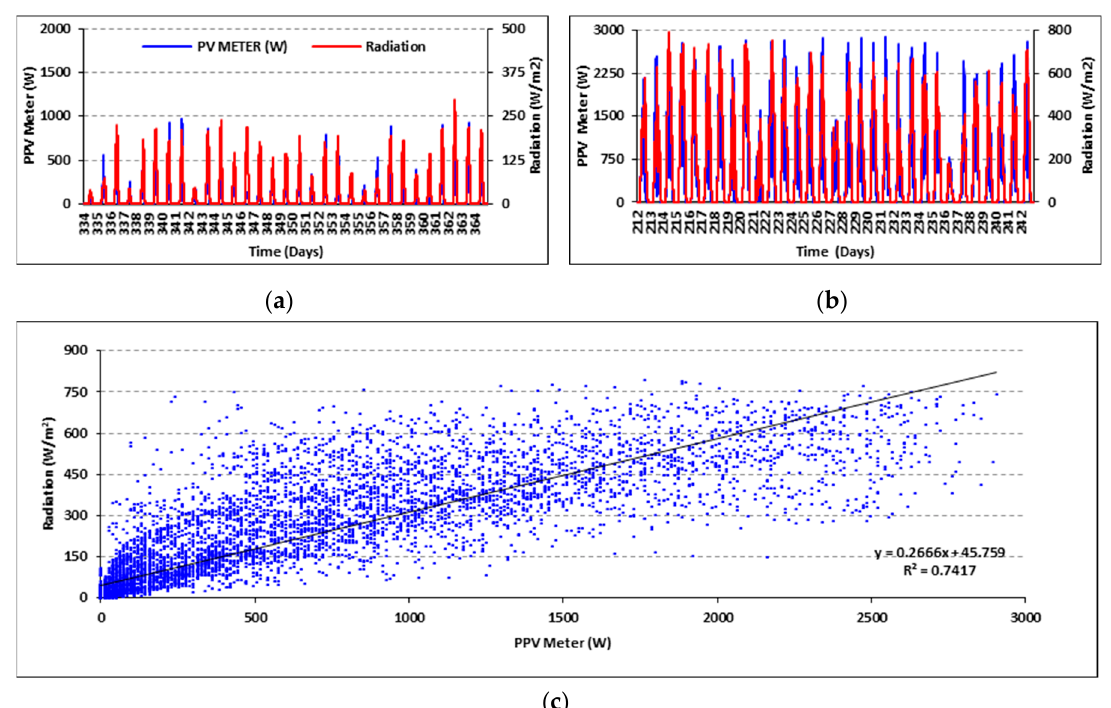
Figure 2. Electricity produced by the PV system vs. solar radiation measurements in Waddington,